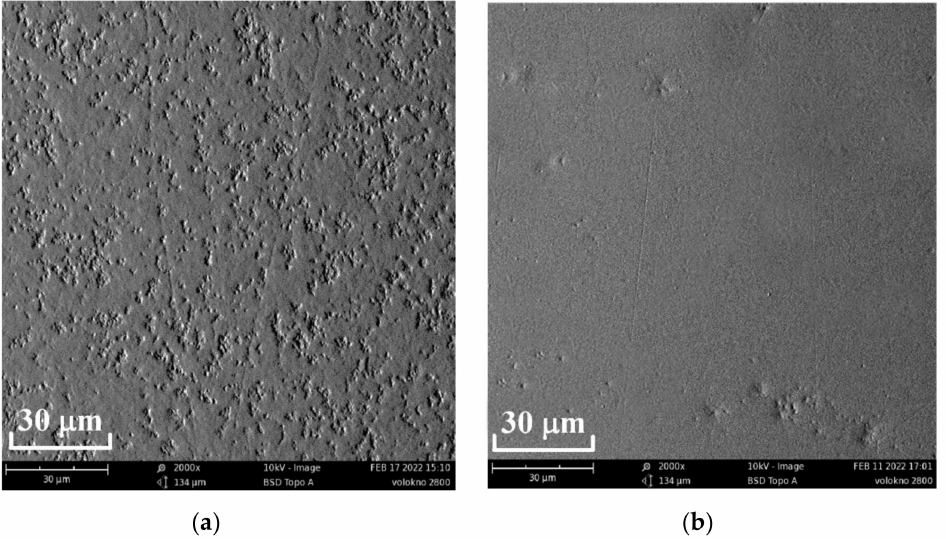
Figure 12. SEM images of cutting plate surfaces with TiAlN coatings deposited before ( a ) and after removal of a 10 µ m-thick layer from the plate surface by fast argon atoms ( b ).